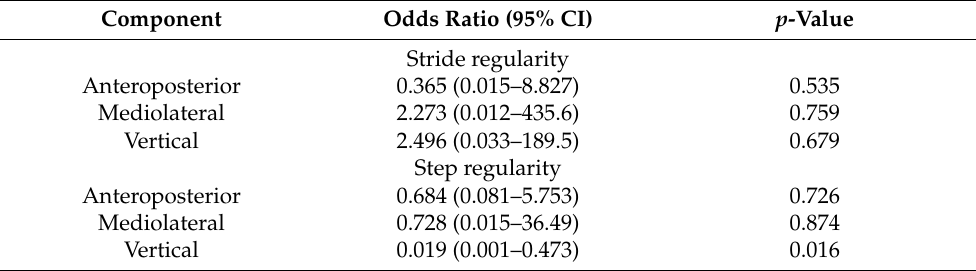
Table 4. Binomial logistic regression analysis of the relationship between MCI and gait regularity after adjusting for covariates ( n = 463). The covariates included age, sex, BMI, history of education, medications, and gait